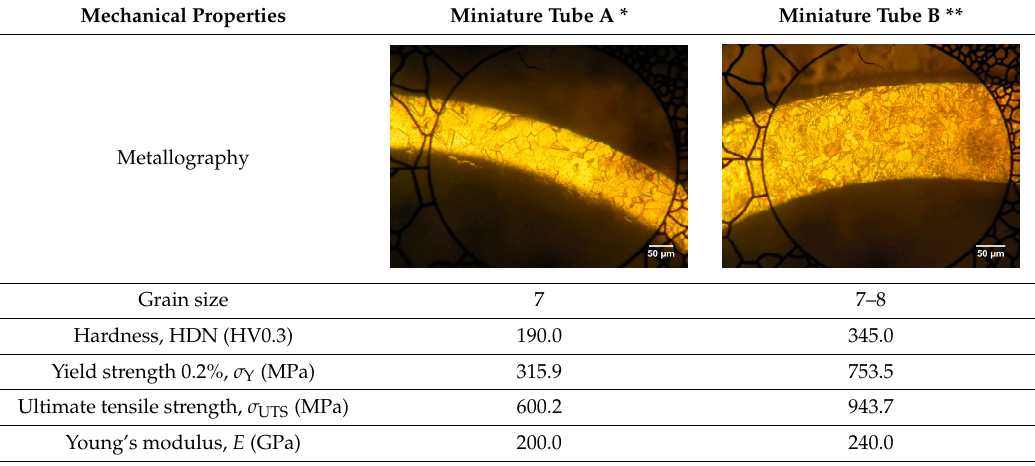
Table 4. Mechanical properties of miniature tube materials [24].